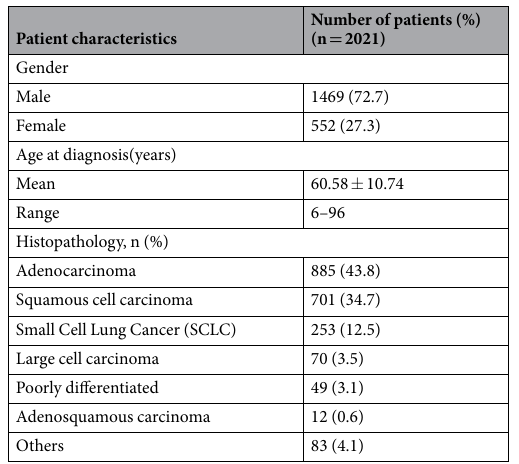
Table 1. Characteristics of patients with lung cancer included in this